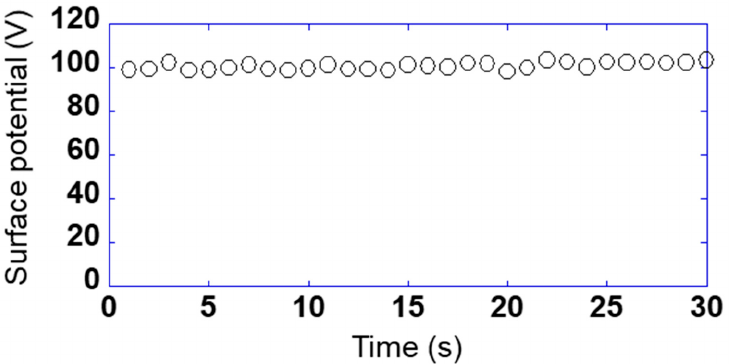
Figure 5. Relationship between the surface potential and measured time while scanning the sensor s 10 at 1 mm/s using sample 1 applied to 100